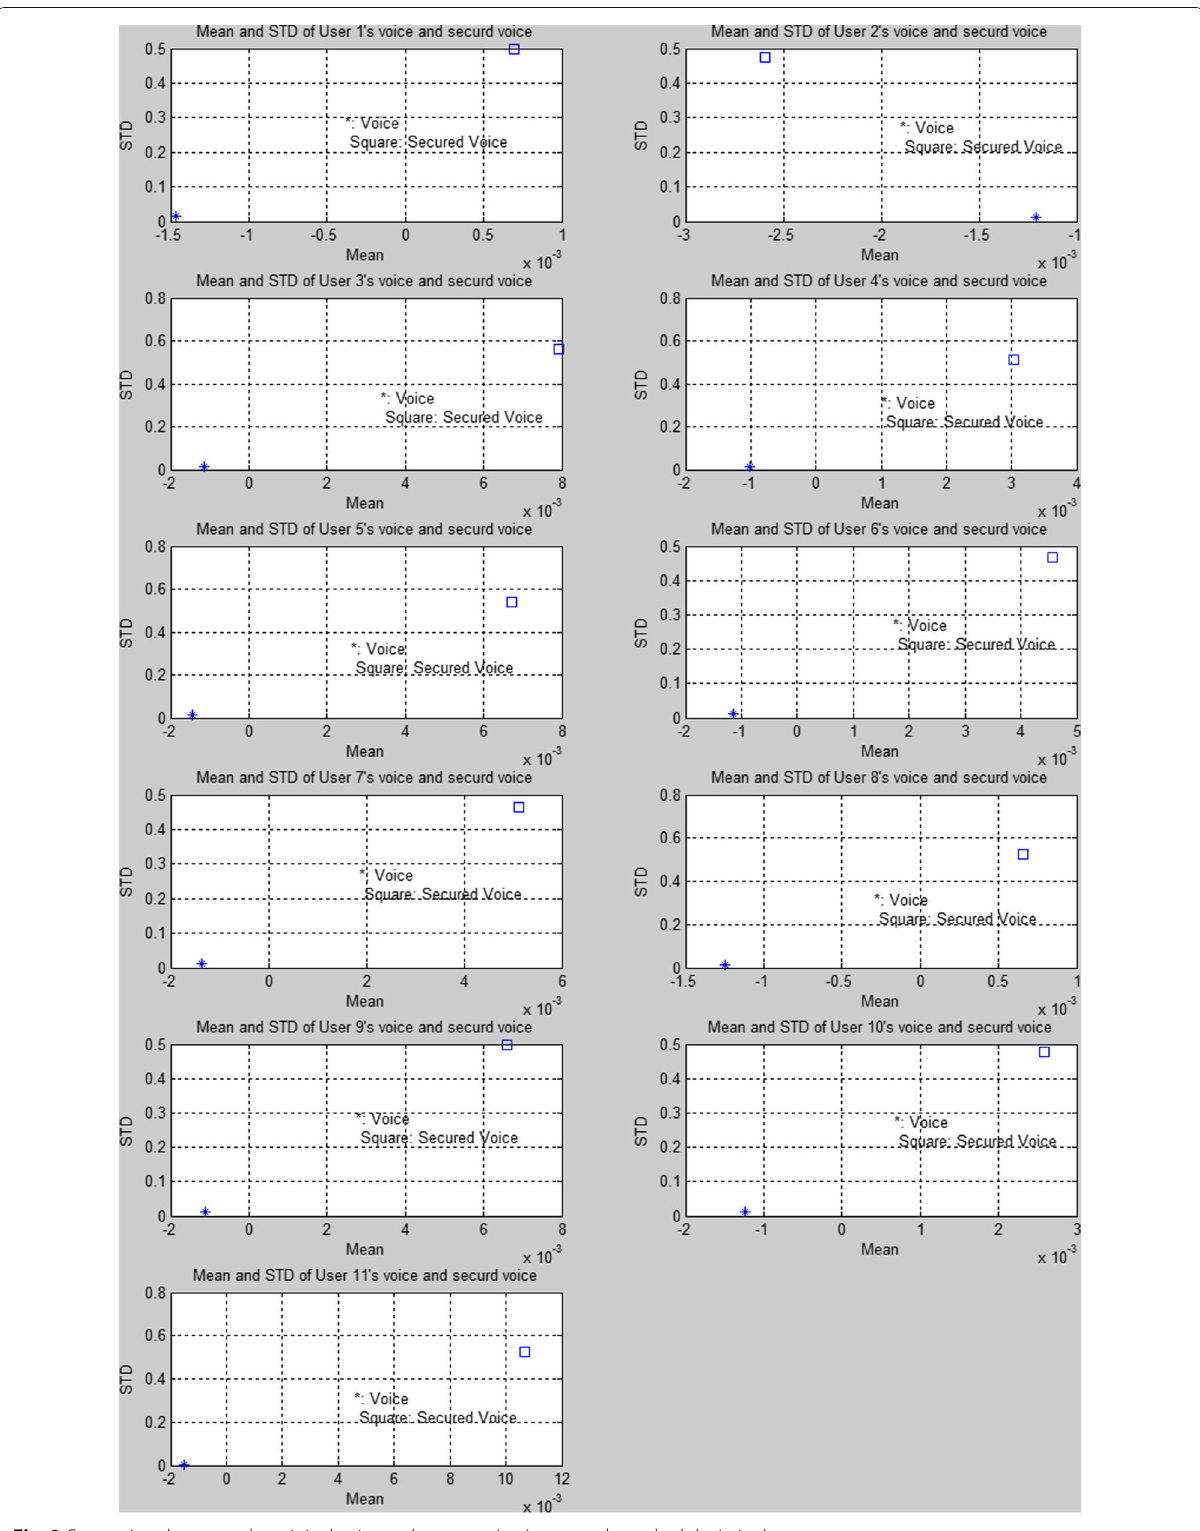
Fig. 9 Comparison between the original voice and secure voice (mean and standard